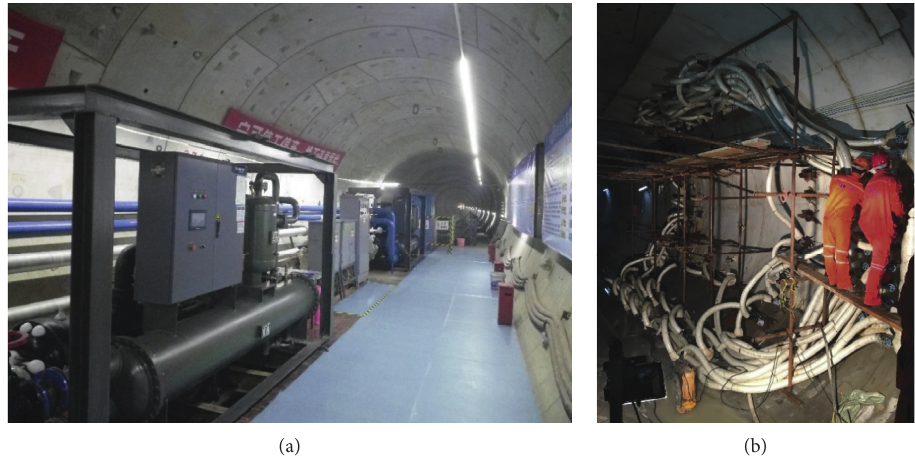
Figure 8: (a) Layout of the freezing station in the tunnel and (b) the installation of the freezing pipe.